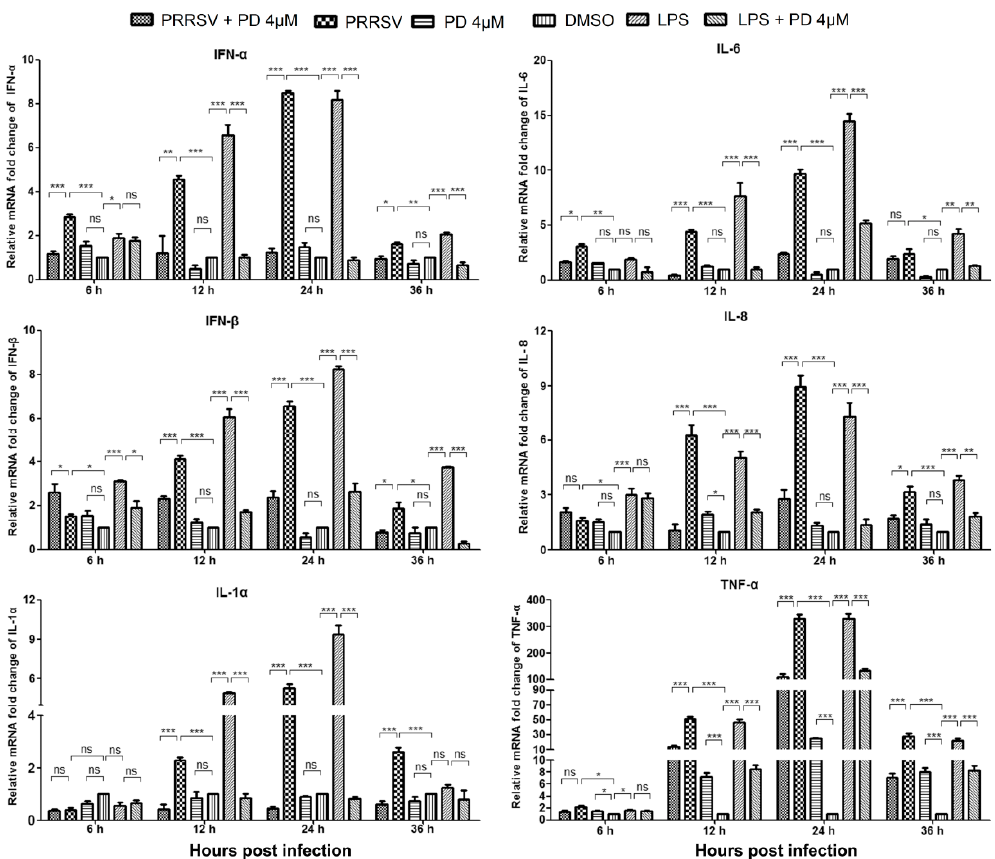
Figure 6. Effect of PD on PRRSV- or LPS-induced cytokine gene expression in PAMs. PAMs were infected with PRRSV GD-HD (0.5 MOI) for 2 h at 37°C and then cultured in fresh medium in the presence or absence of 4 μ M PD. As a parallel positive control, 100 ng/mL of LPS were added to PAMs to stimulate cytokine production. The mRNA level of each cytokine was assessed by RT-PCR. Relative expression (fold change) in comparison with DMSO-treated cells (mock-infected, set as 1) is shown. The data represent the mean values from three independent experiments. Statistical significances are denoted by * p < 0.05, ** p < 0.01, and *** p < 0.001, ns means no significant difference.